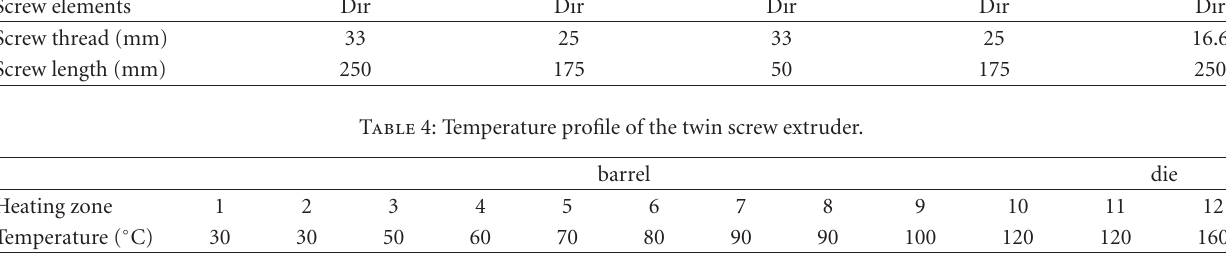
Table 5: Temperature profile of the single screw